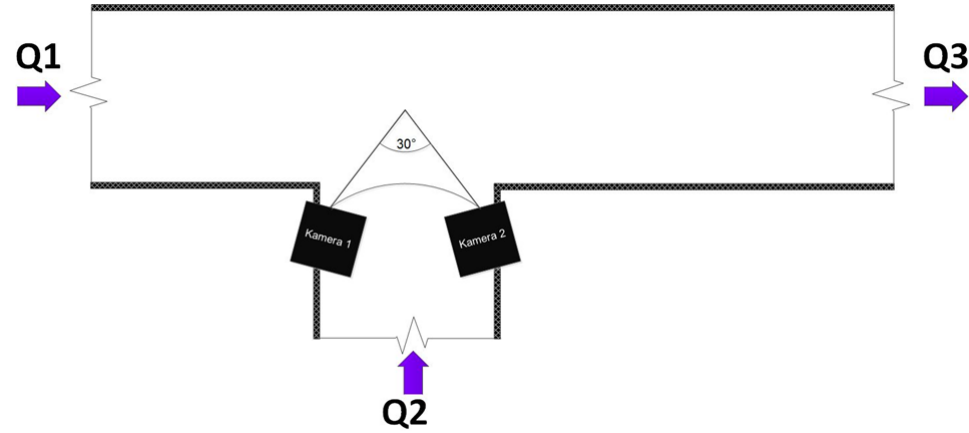
Figure 4. Placement of cameras at testing